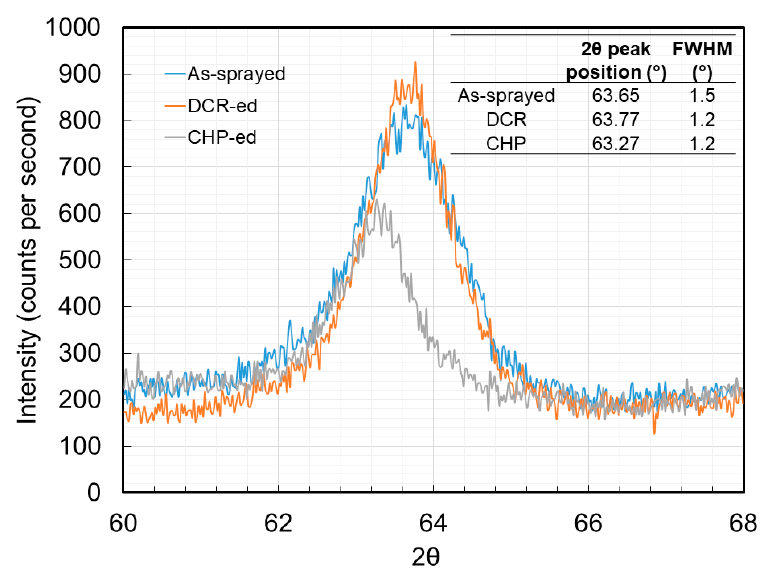
Figure 12. X ‐ ray diffraction data showing a shift in peak position after post ‐ processing. Figure 12. X-ray diffraction data showing a shift in peak position after